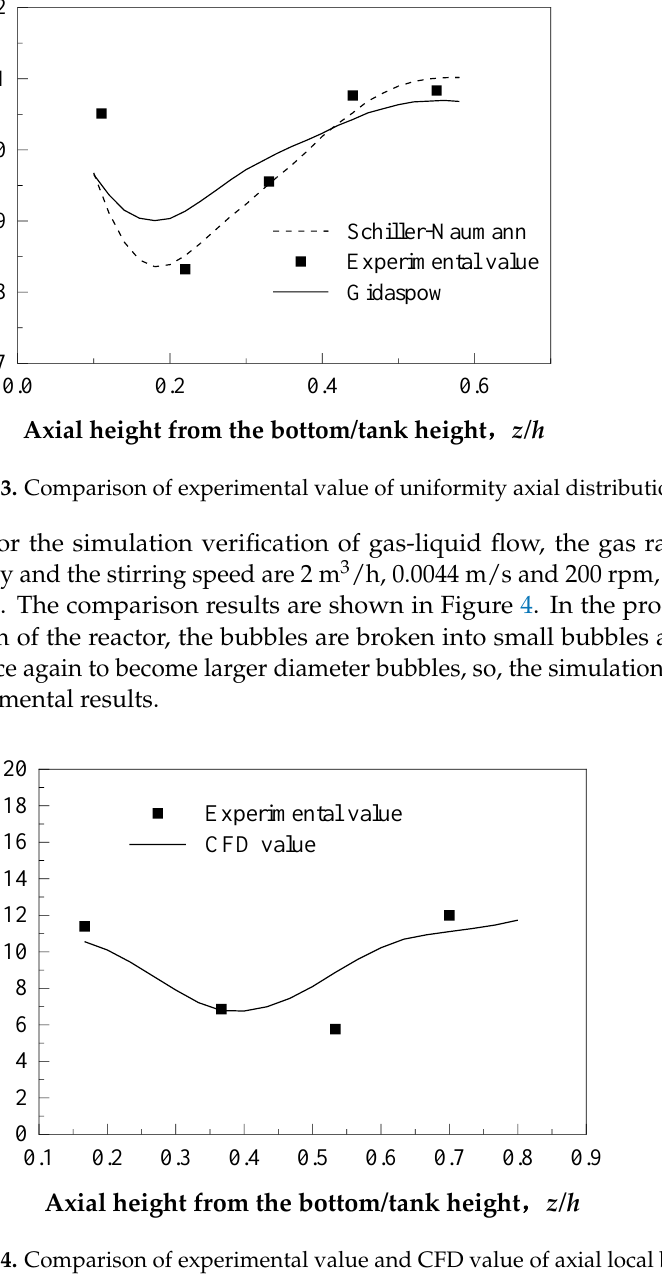
Figure 4. Comparison of experimental value and CFD value of axial local bubble diameter.